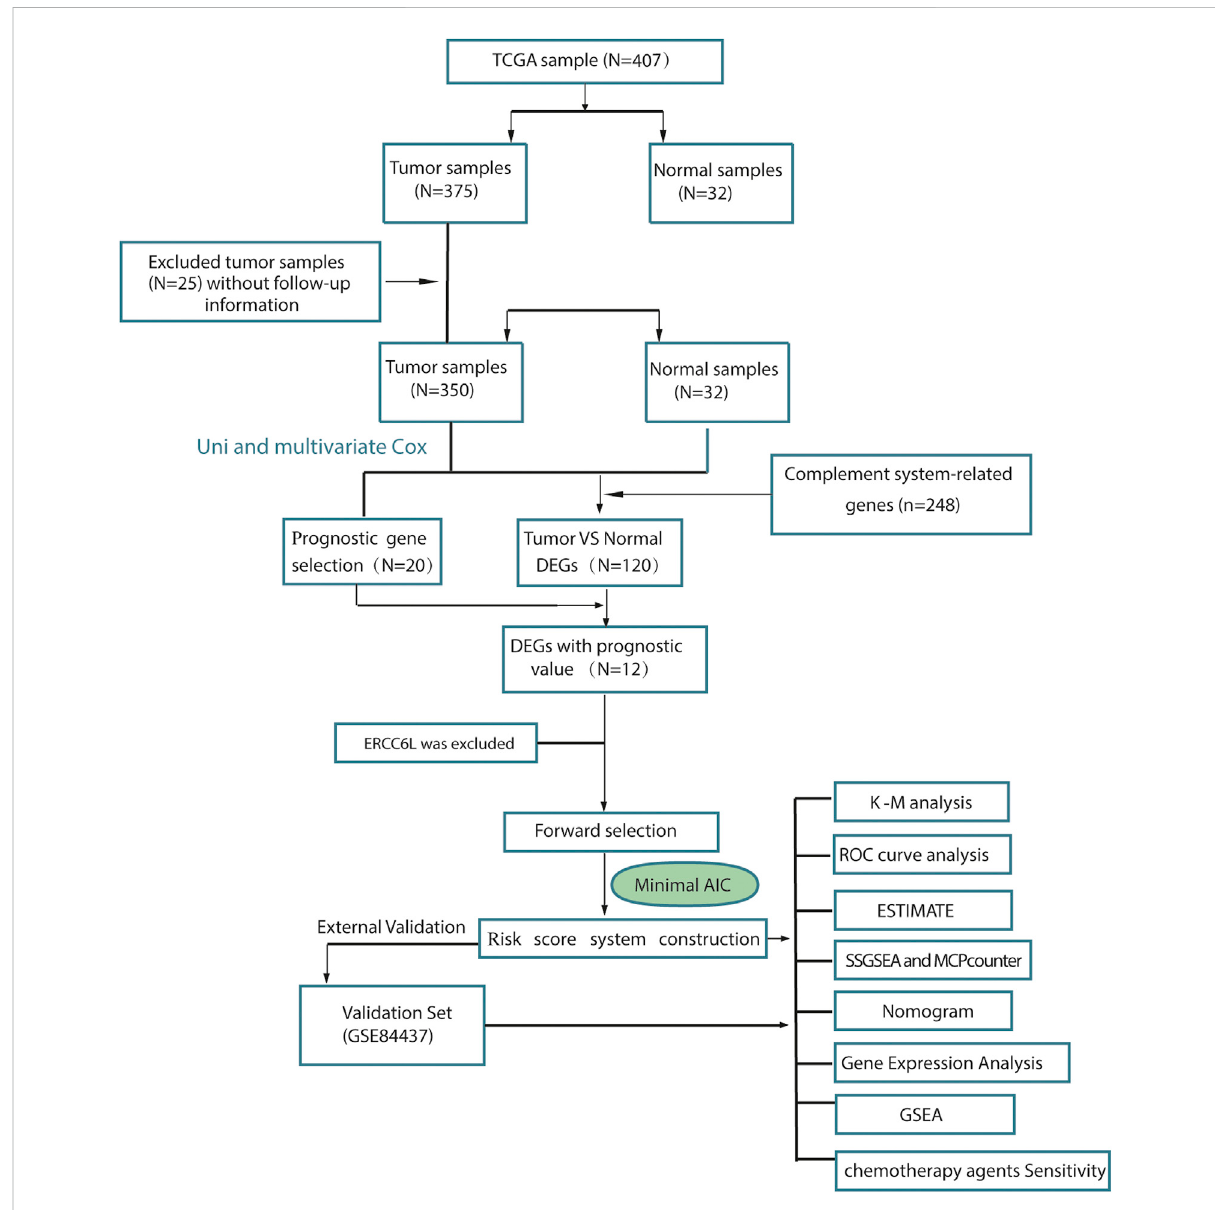
FIGURE 1 Flow diagram of data collection and analysis in the present